Question: Summarize what this figure shows in one sentence.
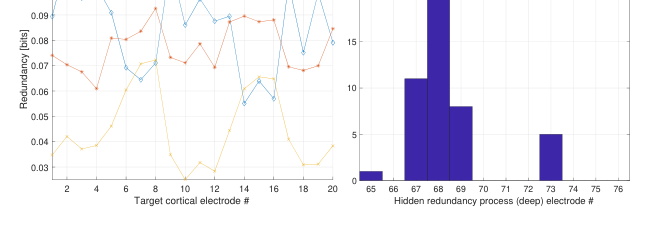
Answer: Left: Redundancy (24) – (25) in intracranial EEG data. Right: Histogram of the sources that are chosen as the hidden redundancy process for the targets 6 – 8 and 14 – 16.